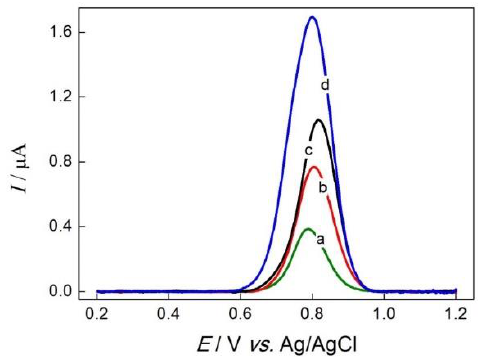
Figure 7. DPV voltammograms obtained in 0.2 mol L −1 PBS pH 8.0 containing 5.0 μmol L −1 of SMZ for the following electrodes: (a) bare GC, (b) GC/GO, (c) GC/rGO and (d) GC/rGO-AuNPs.